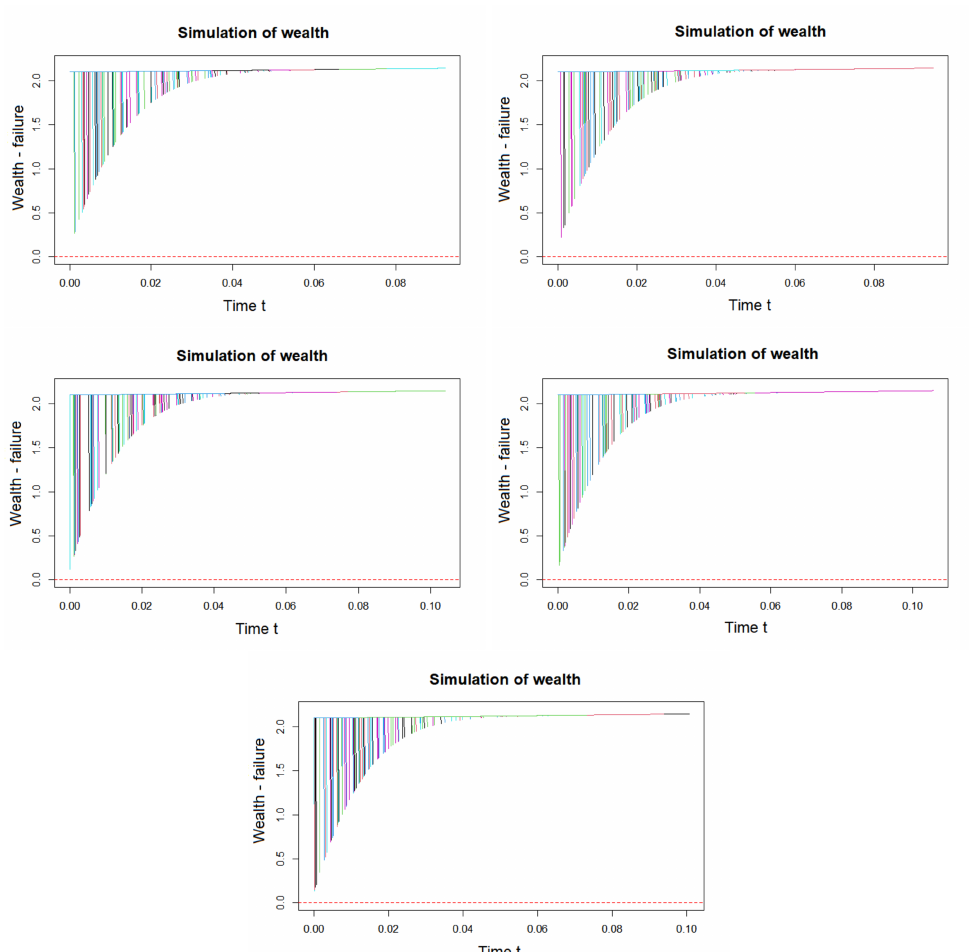
Figure 6. Monte Carlo simulations of wealth, for an initial wealth of ω = 2.1027018 and a premium of π =